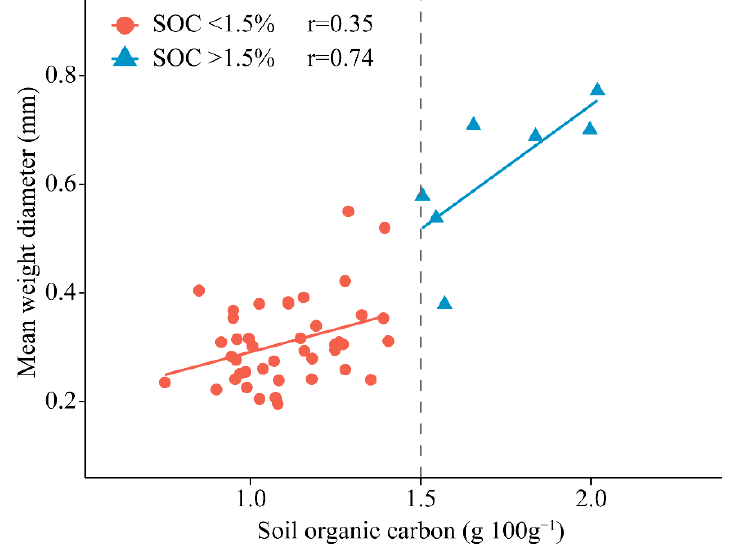
Figure 3. Scatterplot of soil mean weight diameter (MWD) versus soil organic carbon (SOC). We divided the data into two parts using a SOC threshold of 1.5 g 100 g − 1 . Solid lines for both parts were fitted by linear regression.